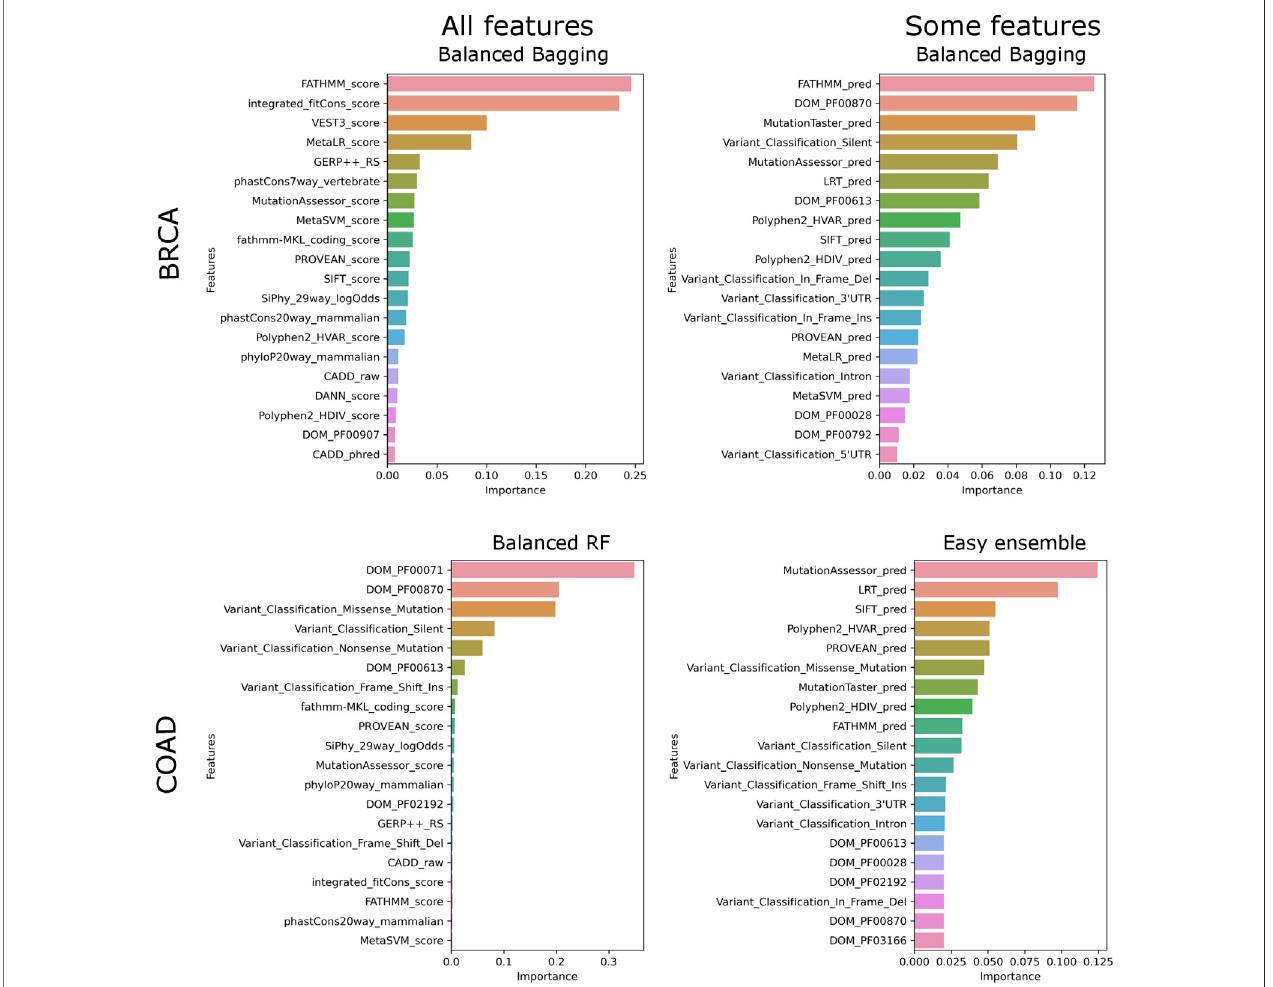
FIGURE 2 | Top features contributing to models. The top 20 features and their contribution to the best model are plotted for “ all ” and “ some ” feature sets.